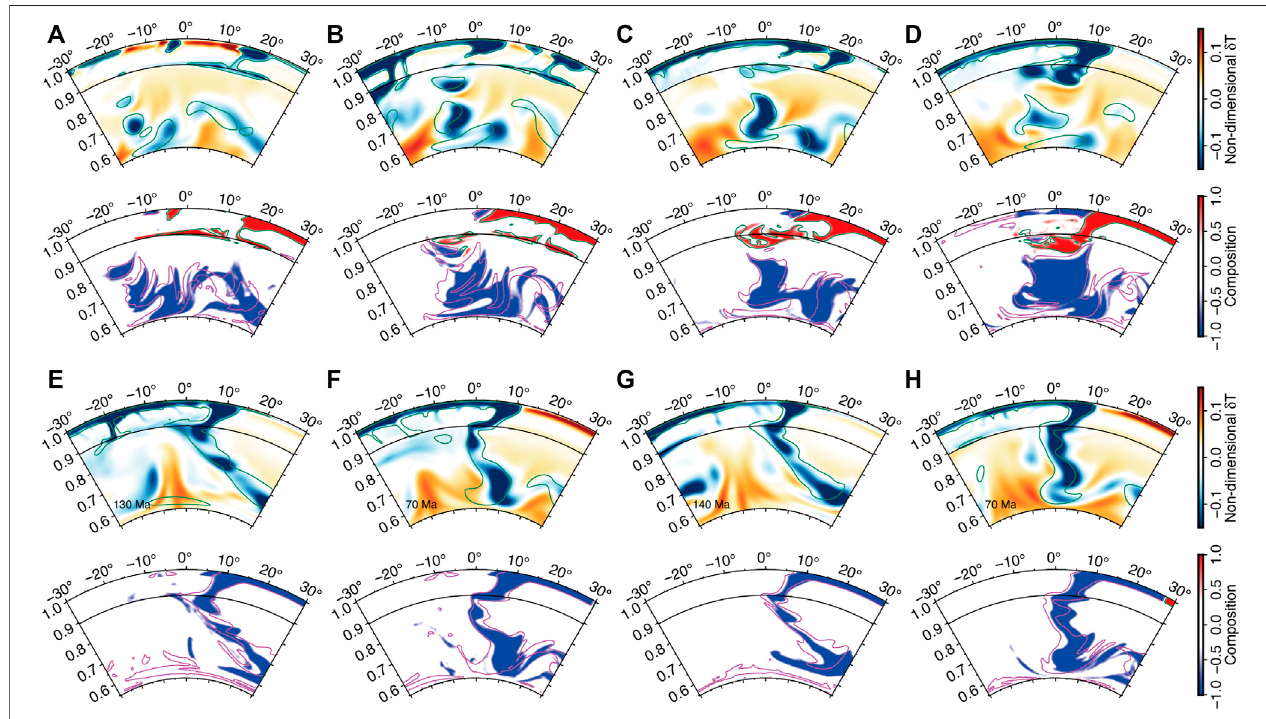
FIGURE 5 | Slab structures of the Izanagi-Paci fi c Plate beneath the Eastern Aisa for case 2 in which the plate motion history is from Young et al. (2019). (A – D) are present-day temperature and composition of slab structures for cross-sections P1-P4 in Figure 1 , respectively. (E,F) are temperature and compositional fi elds from cross-sections through the NCC at 130 Ma and 70 Ma, respectively. (G,H) are temperature and compositional fi elds from cross-sections through the SCB at 140 Ma and 70 Ma, respectively. In panels of temperature fi elds, the green lines indicate contours of non-dimensional residual temperature δ T of -0.05 from case 1 at the same time and cross-section. In panels of compositional fi elds, the magenta and green lines indicate compositional contours of -0.5 and 0.5 from case 1 which associated with the Izanagi slab and the Paci fi c slab, respectively.